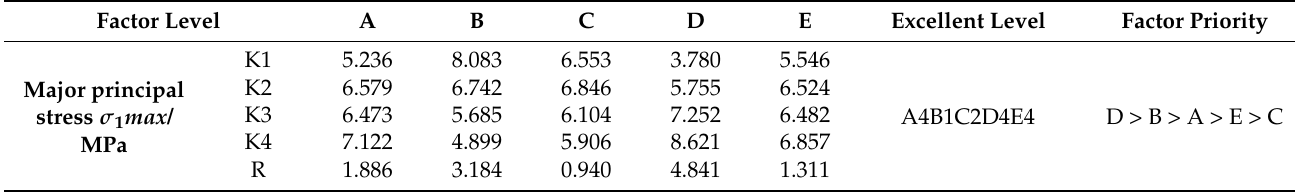
Table 5. Analysis of the degree of influence of various factors on principal stress σ 1 .